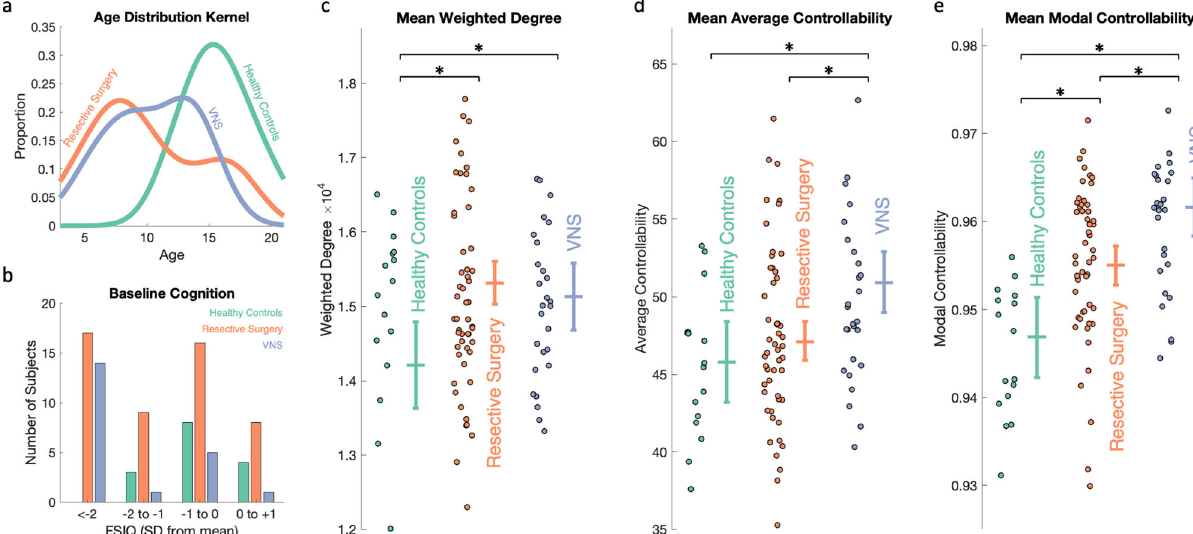
Fig. 2 Drug-resistant epilepsy is associated with higher mean weighted degree, average controllability and modal controllability compared to healthy controls. a Kernel plot of age distributions which were signi fi cantly different between the groups (Kruskal – Wallis test, p < 0.0001). b Baseline cognitive function measured by full-scale IQ (FSIQ) classes compared to age-corrected normal population. More epilepsy patients (resective surgery and VNS) were in the lower classes (Chi-Sq Test, p = 0.01). c – e Scatter plots of c mean weighted degree, d mean average controllability and e mean modal controllability for each group. Besides the scatter, plots are estimated marginal means (±95% Wald con fi dence intervals) following correction for age, sex, cognitive function and, for the controllability metrics, mean weighted degree. Multiple comparisons were adjusted for by the least signi fi cant difference. Both groups of epilepsy patients had a higher weighted degree compared to controls ( p = 0.001 for resective surgery; p = 0.02 for VNS groups). The VNS group had signi fi cantly higher mean average controllability compared to both the controls ( p = 0.003) and the resective surgery ( p = 0.001) group. Both groups had higher mean modal controllability compared to controls ( p = 0.003 for resective surgery; p = 1 × 10 − 6 for VNS) and the VNS group was even signi fi cantly higher than the resective surgery group ( p = the number of streamlines connecting each of 253 cortical and